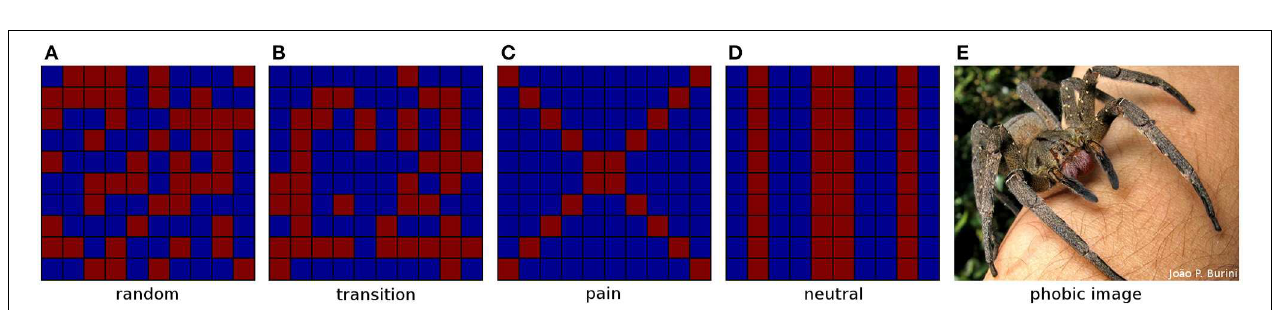
FIGURE A2 | Protocol for reasoned fear. Starting from (A) , random transitions of pixels as in (B) occur once a second until an icon fully forms. Reward (C) and pain (D) icons are pre-conditioned, but